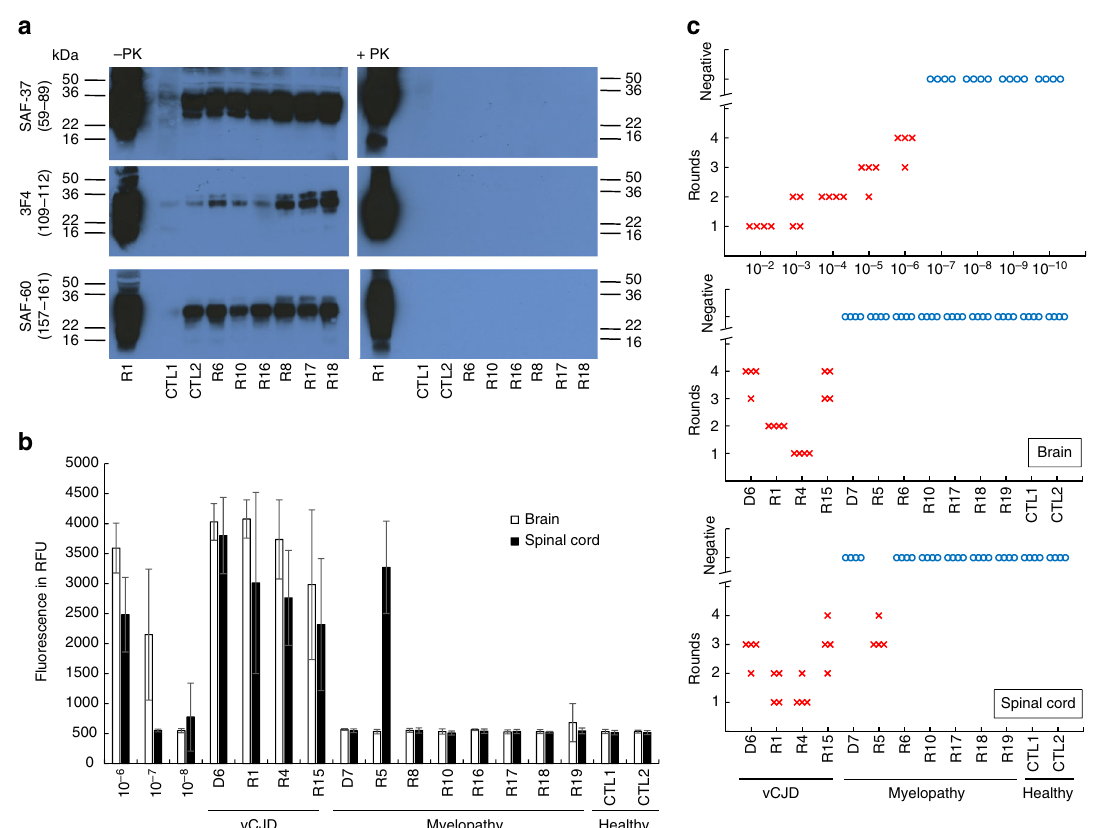
Fig. 4 Biochemical detection of abnormal PrP in CNS samples of primates. a Direct detection of PrP accumulation in spinal cord samples from primates after puri fi cation in the absence ( − PK) or in the presence (+PK) of proteolysis (40 µ g/ml proteinase K for 10 min) detected with 3F4, Saf-37 and Saf-60 antibodies. The equivalent of the same amount of material (8 mg) was deposited in each line. Corresponding uncropped western blots are shown in Supplementary Fig. 5. b Ampli fi cation of abnormal PrP by RT-QuiC in brain (white bars) or spinal cord (black bar) primate samples. The mean fl uorescence from six replicates (two independent experiments with triplicates) after 50 h of ampli fi cation is presented here. c Ampli fi cation of abnormal PrP by PMCA reaction in brain or spinal cord primate samples. Four individual replicates of each sample, including serial dilutions of positive control, were tested. For each sample at each round, the PrP res positive replicates are fi gured (red crosses). The blue circles fi gure the negative replicates after fi ve runs. D6, R1, R4 and R15: vCJD primates; D7, R5, R6, R8, R10, R16, R17, R18, R19: myelopathic primates; CTL1, CTL2: healthy primates. Details on each primate